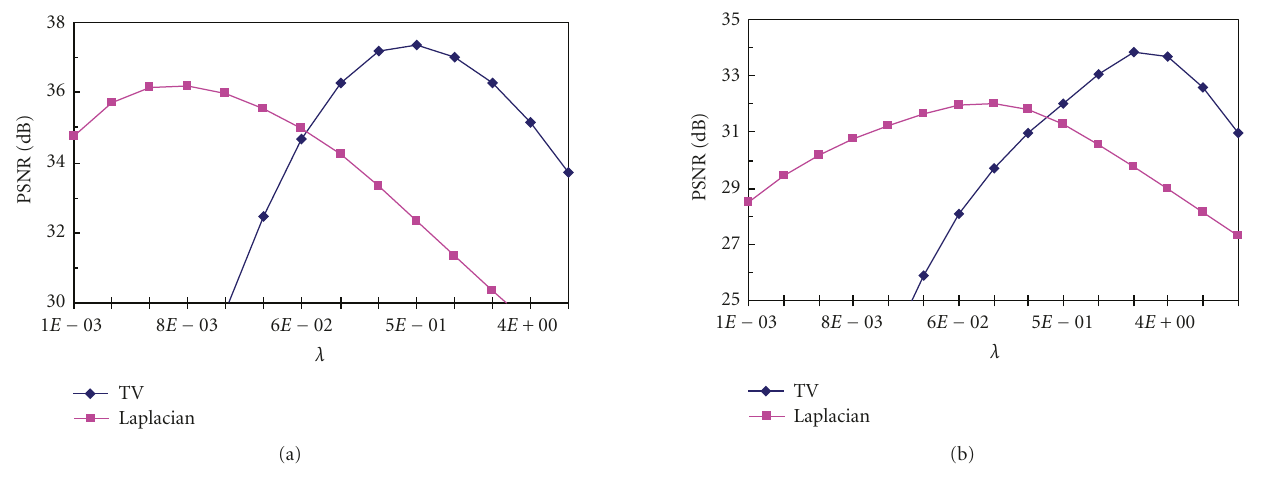
Figure 11: PSNR values versus the regularization parameter in the nonsynthetic “Foreman” experiments: (a) the “motion only” case, and (b) the “noise” case.